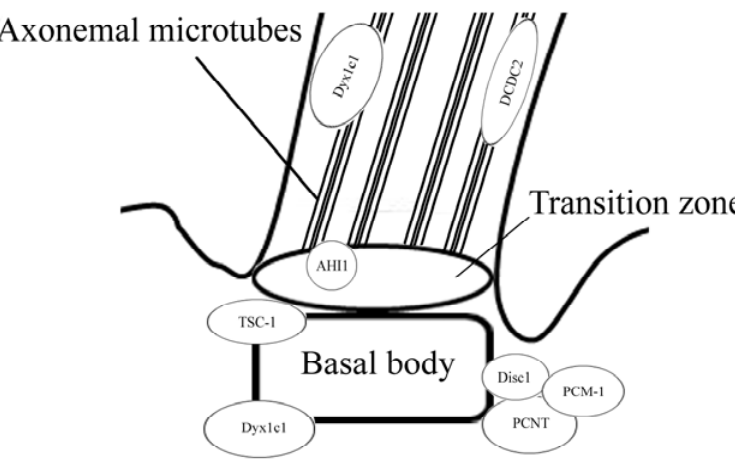
Figure 1. Ciliary proteins localization in a cilium. Most of the proteins are localized in the basal body, AHI1 is localized in the transition zone, and two of the proteins are localized in the axoneme.